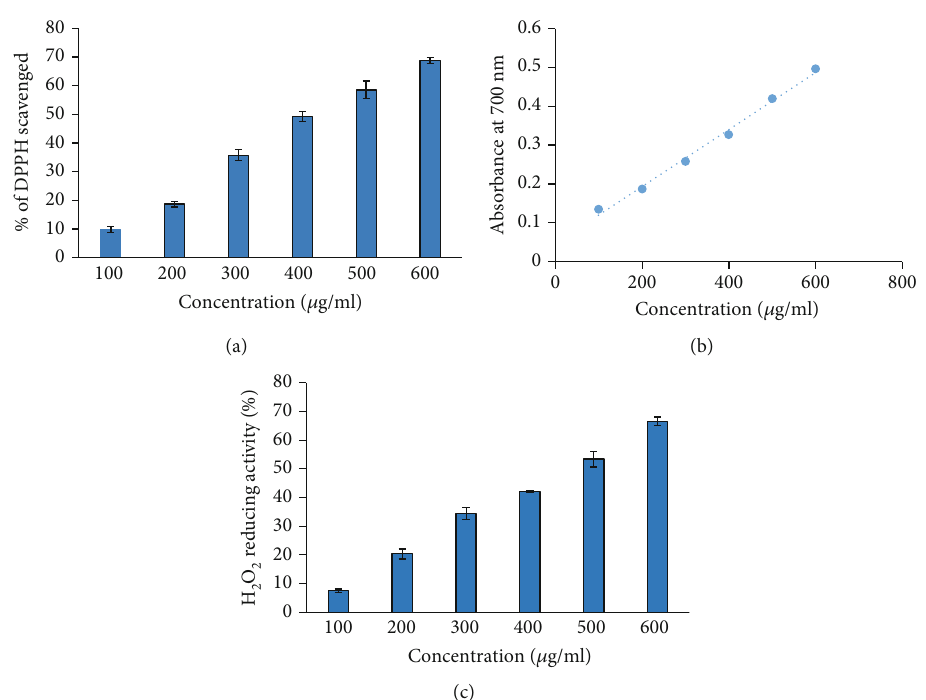
Figure 1: (a) Percent free radical scavenging activity of 6-gingerol. The bars show percent free radical activity vs. concentration ( μ g/ml) of 6- gingerol ( p < 0 : 05 ). (b) Reducing power of 6-gingerol in terms of absorbance at 700nm. x -axis indicates the various concentrations of 6- gingerol. y -axis shows the corresponding absorbance at 700nm. (c) H to various concentrations of 6-gingerol (100 – 600 μ g/ml). The results are presented as means ± SEM ( n = 3 , p < 0 : 05